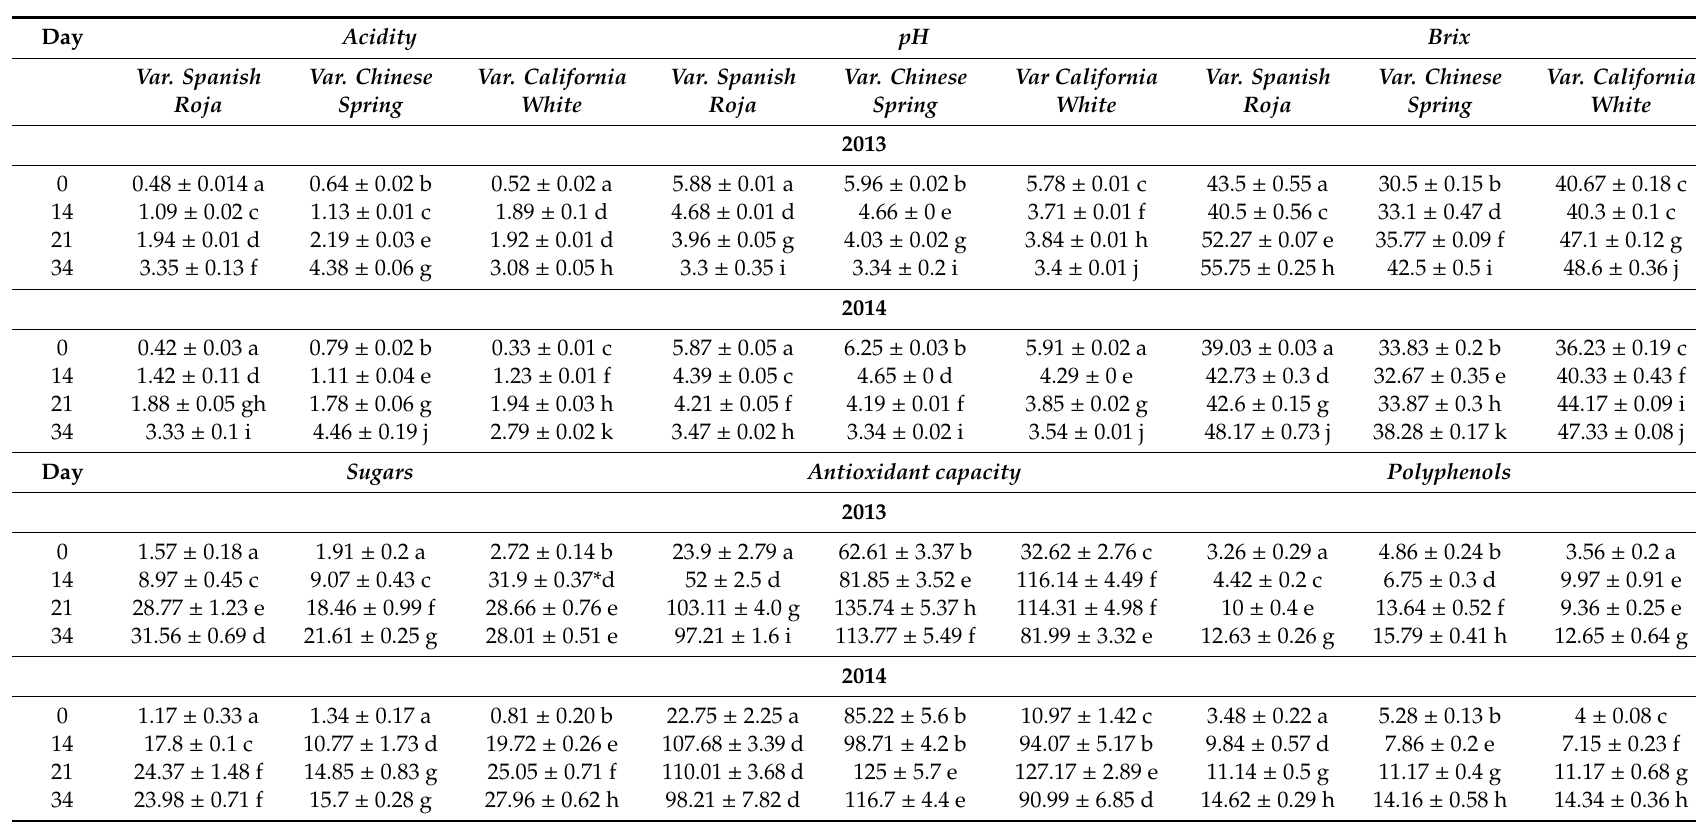
Table 1. Acidity, pH, soluble solids ( ◦ Brix), reducing sugars, antioxidant capacity, and polyphenols (grams of gallic acid equivalent per kg of lyophilized sample) of the garlic varieties Spanish Roja , Chinese Spring, and California White in two consecutive